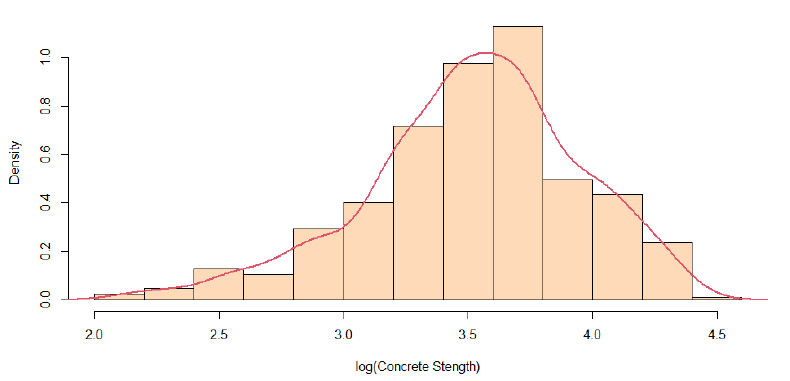
Figure 2. The histogram of the logarithm transformation of CS and its density curve.